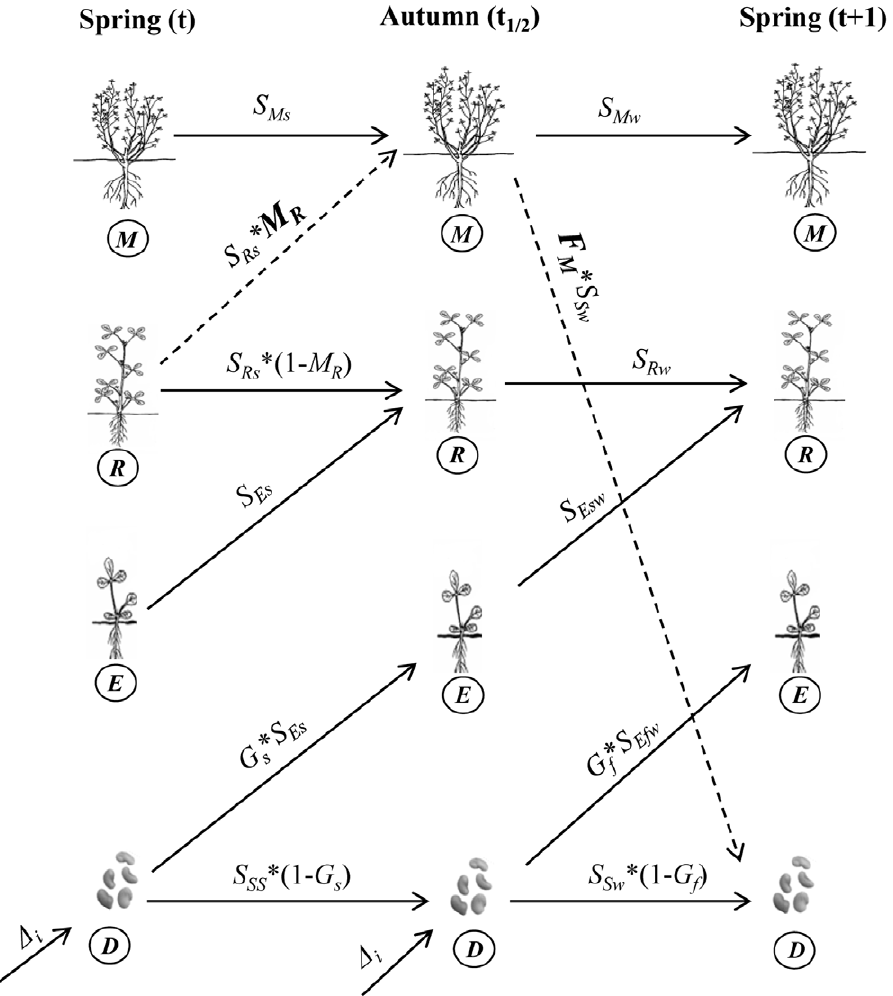
Figure 1. Life cycle diagram of feral alfalfa used in defining the transitions. It comprises of four distinct stages including dormant seeds in the seedbank ( D ), emerged seedlings ( E ), rosettes ( R ) and adult plants ( M ), and two time periods namely spring ( t ) and autumn ( t 1 = 2 ). The dashed arrows illustrate reproductive transitions. The function associated with each arrow corresponds to the transition coefficient from i th stage to the j th stage and the density dependant parameters in the functions are denoted by bold letters. The diagram includes an immigration component D i which represents the seed input into the population from external sources (i.e. recruitment subsidy). Seeds in the seedbank either germinate [spring ( G s ), autumn ( G f )] or remain in the seedbank via survival [summer ( S Ss ), winter ( S Sw )]. Seedlings recruited in spring survive during summer ( S Es ) and winter ( S Esw ) to form rosettes the following spring. The seedlings recruited in autumn survive the winter ( S Efw ), survive the following summer ( S Es ) and become rosettes. Rosettes survive [summer ( S Rs ), winter ( S Rw )] and transform to adult plants ( M R ) upon flowering, which occurs during mid to late summer. Adult plants produce seeds during autumn ( F M ) and the seeds that survives winter ( S Sw ) contributes to the seedbank levels in the following spring. Adult plants persist in the environment through summer ( S Ms ) and winter survival ( S Mw